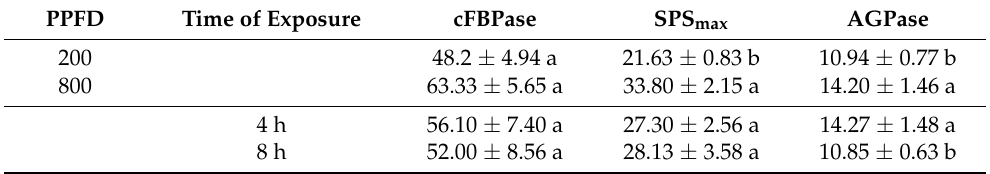
Table 5. Enzymatic activities of cFBAse, SPS max , and AGPase ( µ mol product mg − 1 chl h − 1 ) in leaves of spinach plants grown in a growth chamber under 800 µ mol m − 2 s − 1 (800 PPFD) and 200 µ mol m − 2 s − 1 (200 PPFD) white light intensity, and measured at 4 and 8 h of light of exposure. Mean ± S.E. (n = 12). Different letters indicate significant differences at p = 0.05 (Fisher’s post- hoc test).